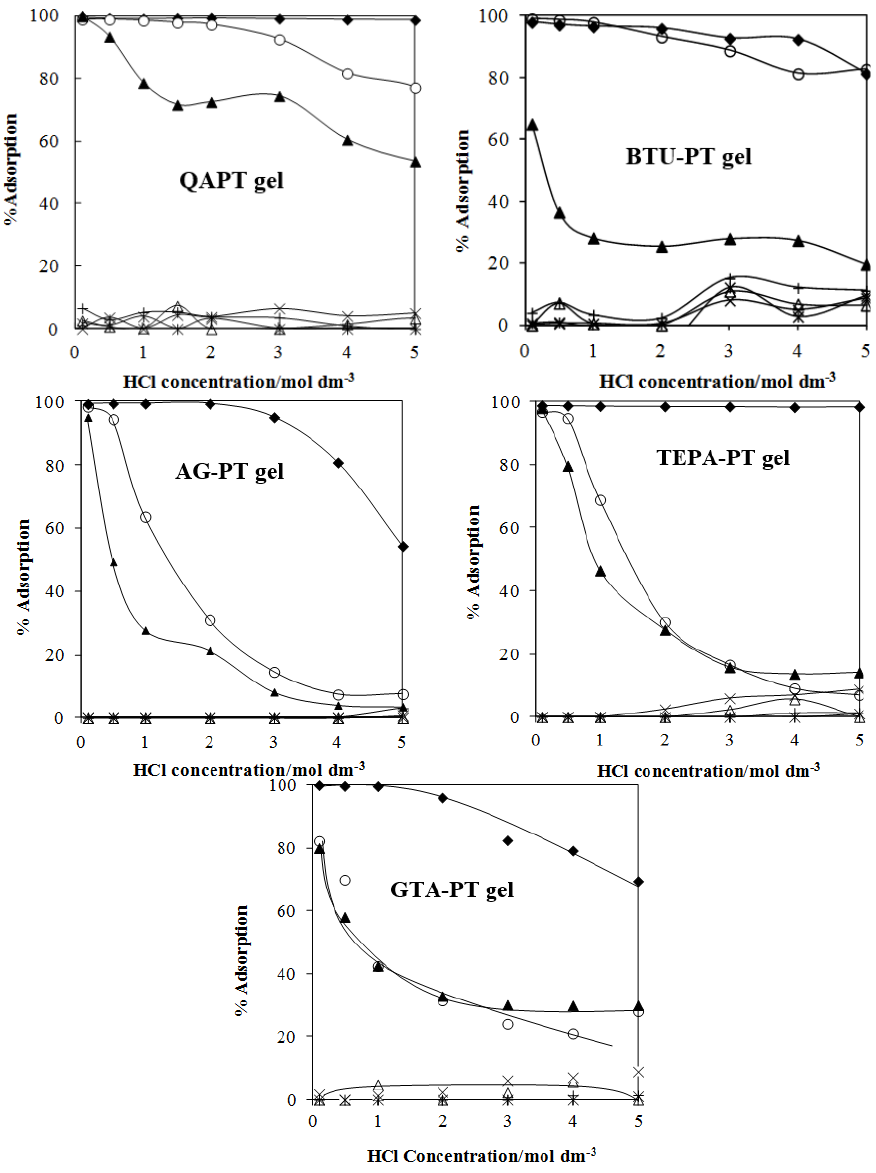
Figure 32. Percentage adsorption of various metal ions on some chemically modified PT gel from varying concentration of hydrochloric acid. ♦ Au(III), ○ Pd(II), ▲ Pt(IV), │ Cu(II), × Zn(II), Δ Ni(II), *